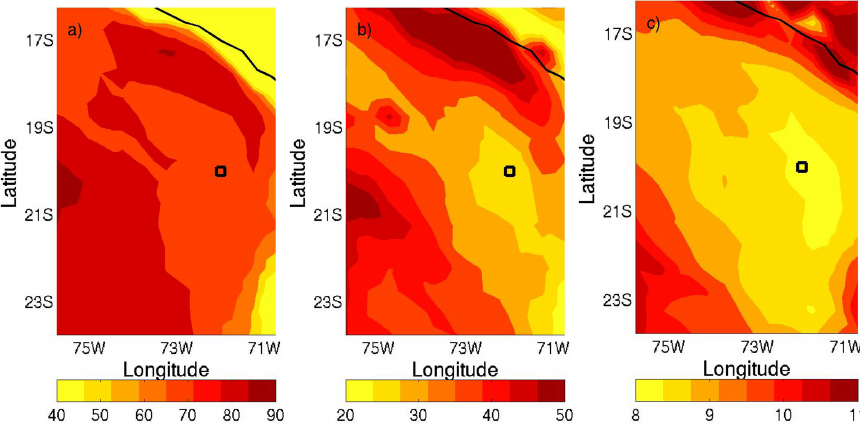
Fig. 2. The average fields of (a) low cloud amount (%), (b) LWP (gm − 2 ) , (c) R e (micron) derived from GOES-10 data during the flight time (see Table 1). Point Alpha is marked as the blue square box.